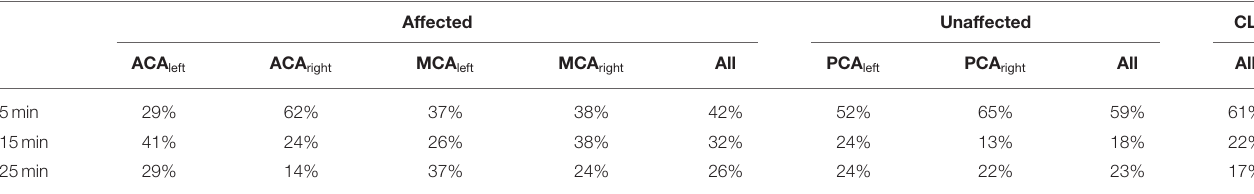
TABLE 3 | Frequency distribution of maximum increase in CBF occurrence (%) for each individual vascular territory and all affected, unaffected, and unaffected contralateral vascular territories and all post-ACZ injection time points. Affected Unaffected CL ACA left ACA right MCA left MCA right All PCA left PCA right All